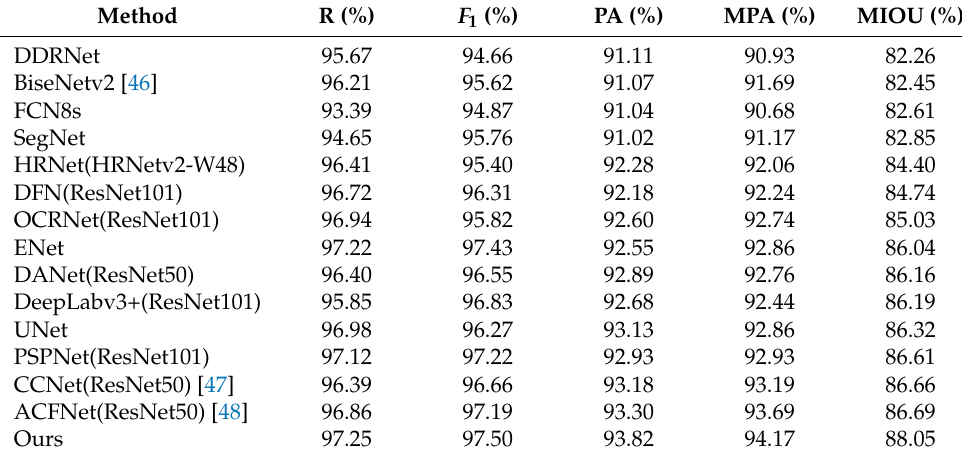
Table 3. Comparison of evaluation indexes of different